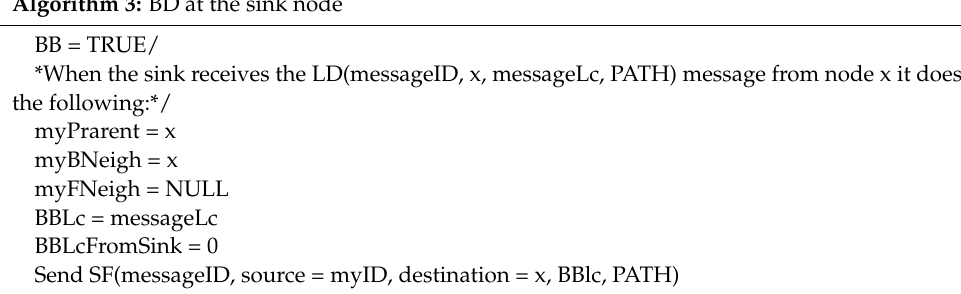
Algorithm 3: BD at the sink node